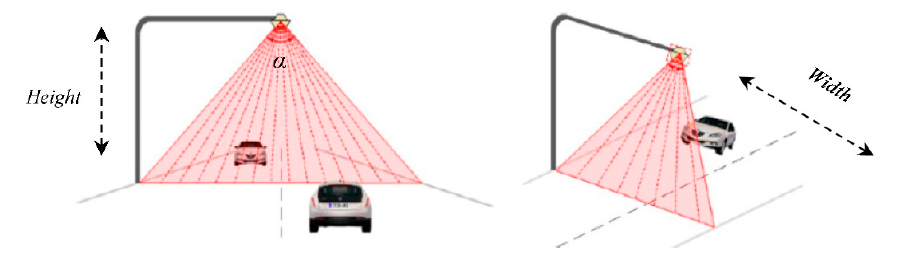
Figure 4. Principle of operation.